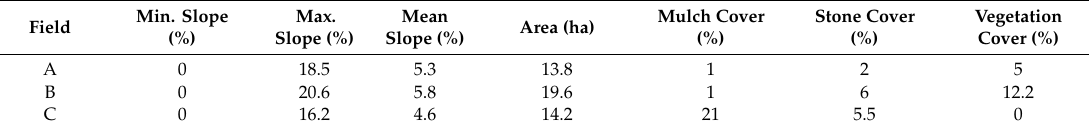
Table A1. Slope and soil cover properties for the di ff erent fields (A, B and C) of the investigation.